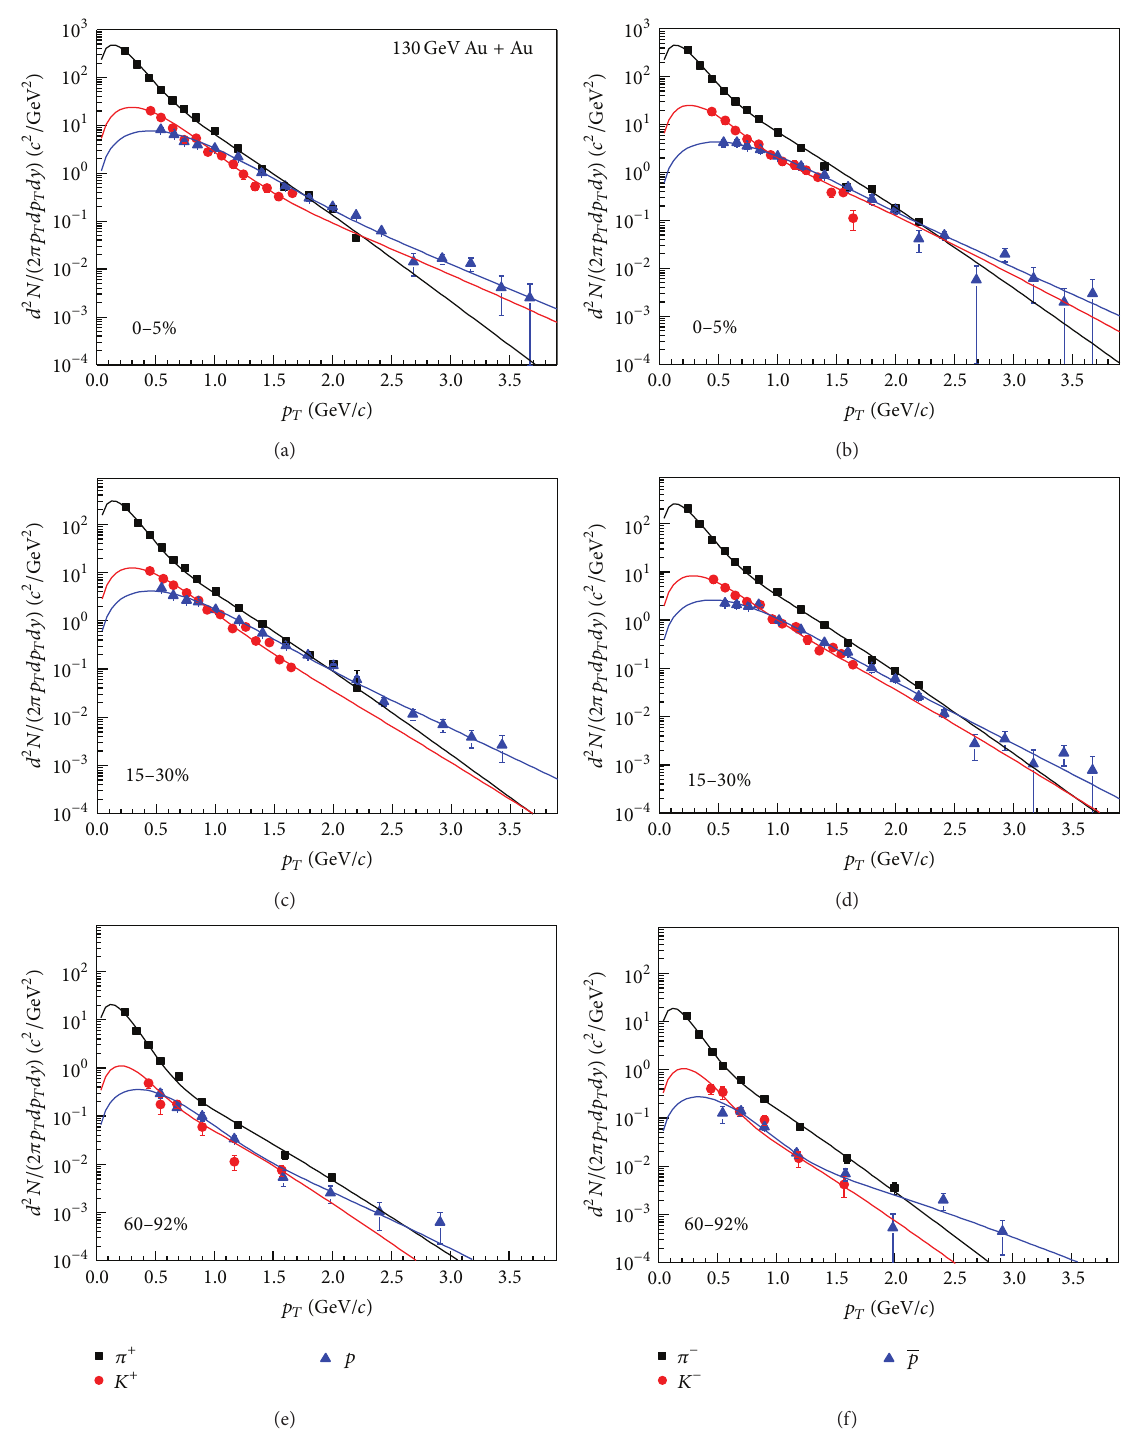
Figure1:Thetransversemomentumdistributionsof 𝜋 + /𝜋 − , 𝐾 + /𝐾 − ,and 𝑝/𝑝 producedinAu-Aucollisionsat √ 𝑠 𝑁𝑁 = 130 GeVwithdifferent centrality classes. The symbols represent the experimental data of the PHENIX collaboration [38, 39], and the curves are our results calculated by the two-component revised Boltzmann